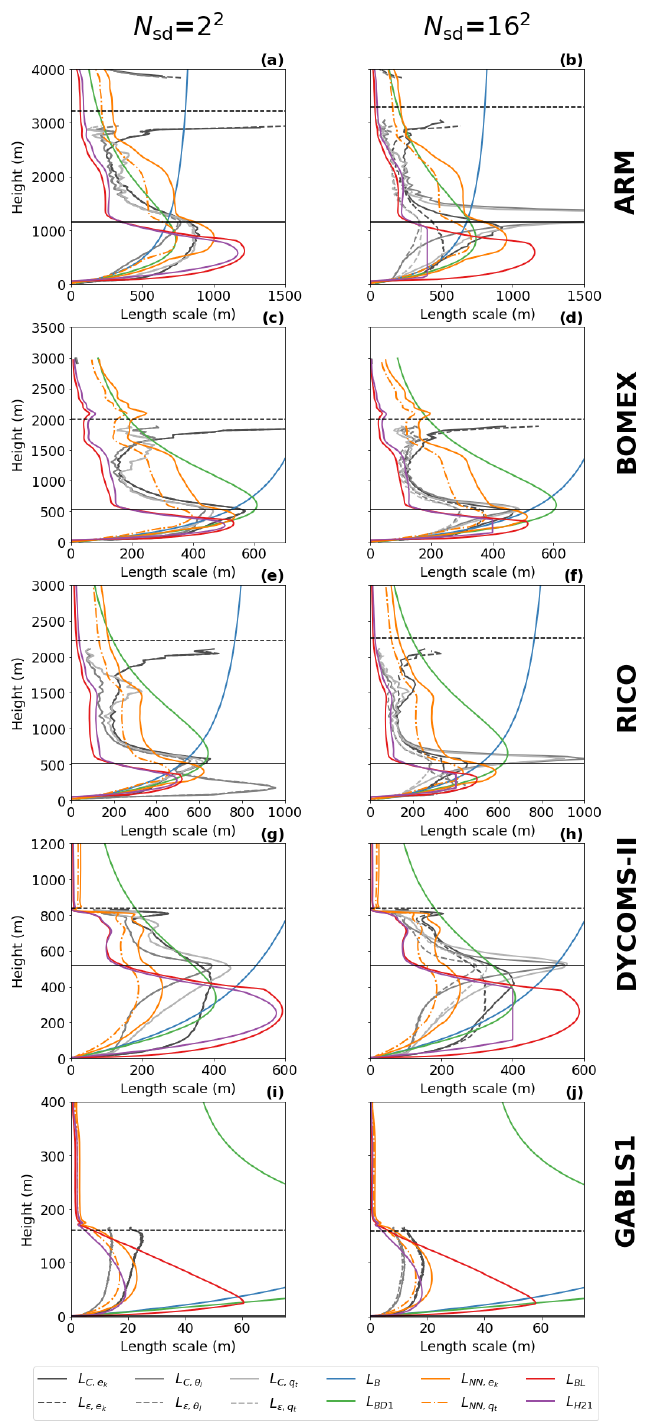
Figure 8. Comparison of the turbulence length scale diagnostics ( L C , e L (cid:101) , θ ) and the turbulence length scale formulations ( L B , L BD 1 , L NN , e l profiles are plotted for the ARM case after 10 h of integration, for the BOMEX and the RICO case after 7 h of integration, and for the DYCOMS-II case and the GABLS1 case after 3 h of integration. L C , q and L (cid:101) , q are not plotted for the dry GABLS1 case. The length scales are computed for the t t second-largest sub-domain size (1st column; a , c , e , g , i ) and the second-smallest sub-domain size (2nd column; b , d , f , h , j ). N sd indicates the number of